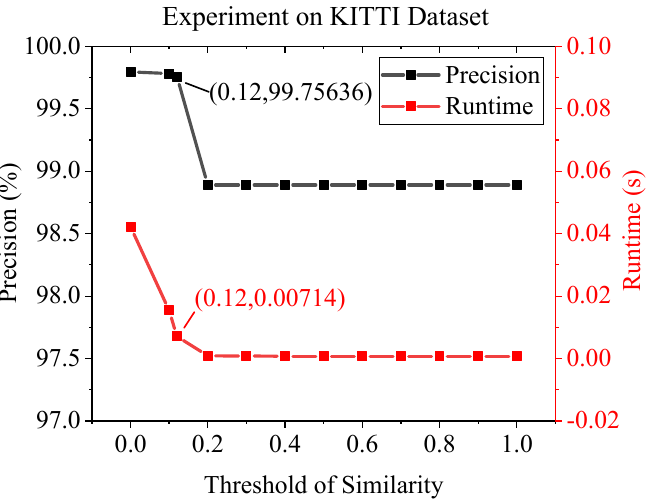
Figure 13. The impact of threshold of similarity on matching precision and average runtime on YFCC100M dataset.